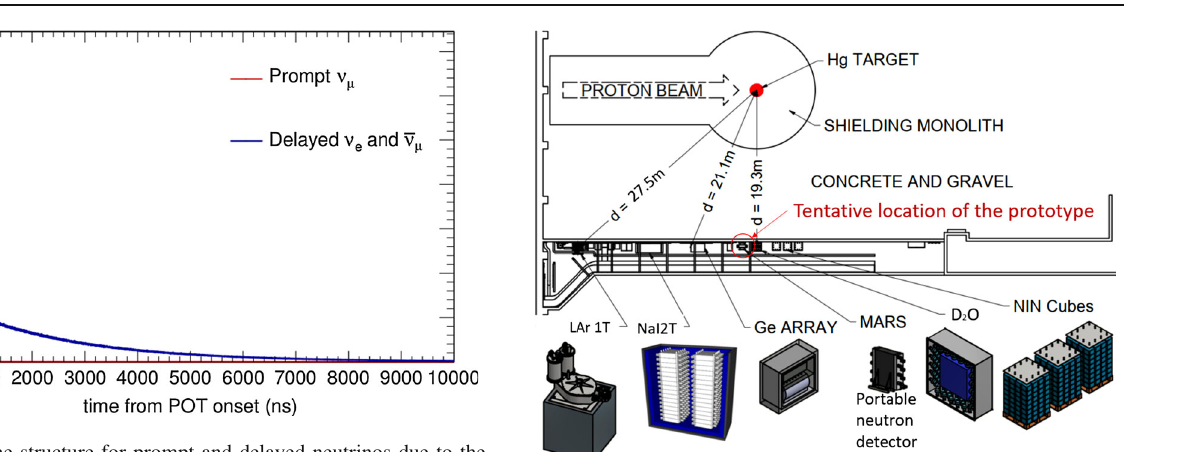
Fig. 13 Time structure for prompt and delayed neutrinos due to the 60-Hz pulses [14]. “Prompt” refers to neutrinos from pion decay, and “delayed” refers to neutrinos from muon decay